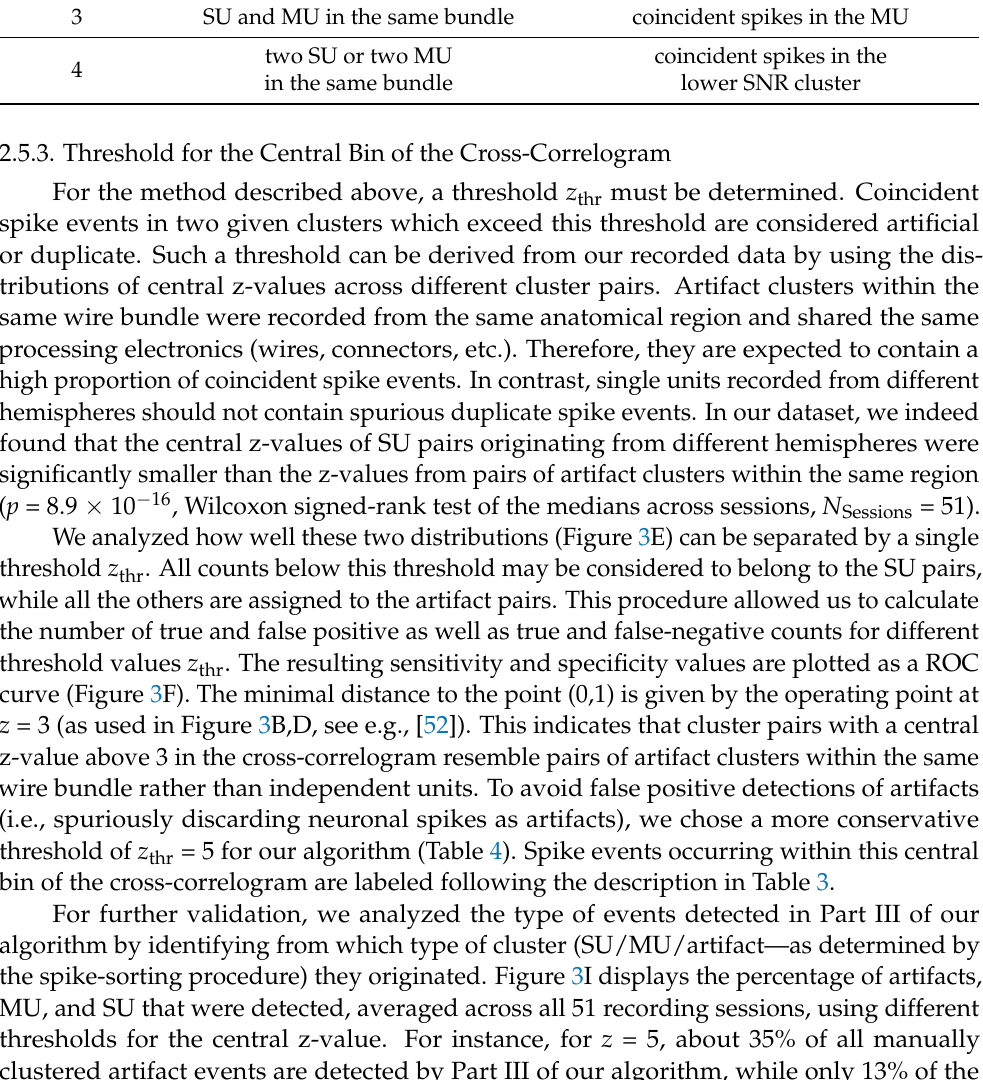
Table 3. Criteria for labelling coincident spikes events in Part III. Case Cluster Combination Spike Events Labelled as Artifacts 1 pair of artifact and (SU or MU) all coincident spike events two clusters in different 2 wire bundles 3 SU and MU in the same bundle coincident spikes in the MU two SU or two MU 4 in the same bundle